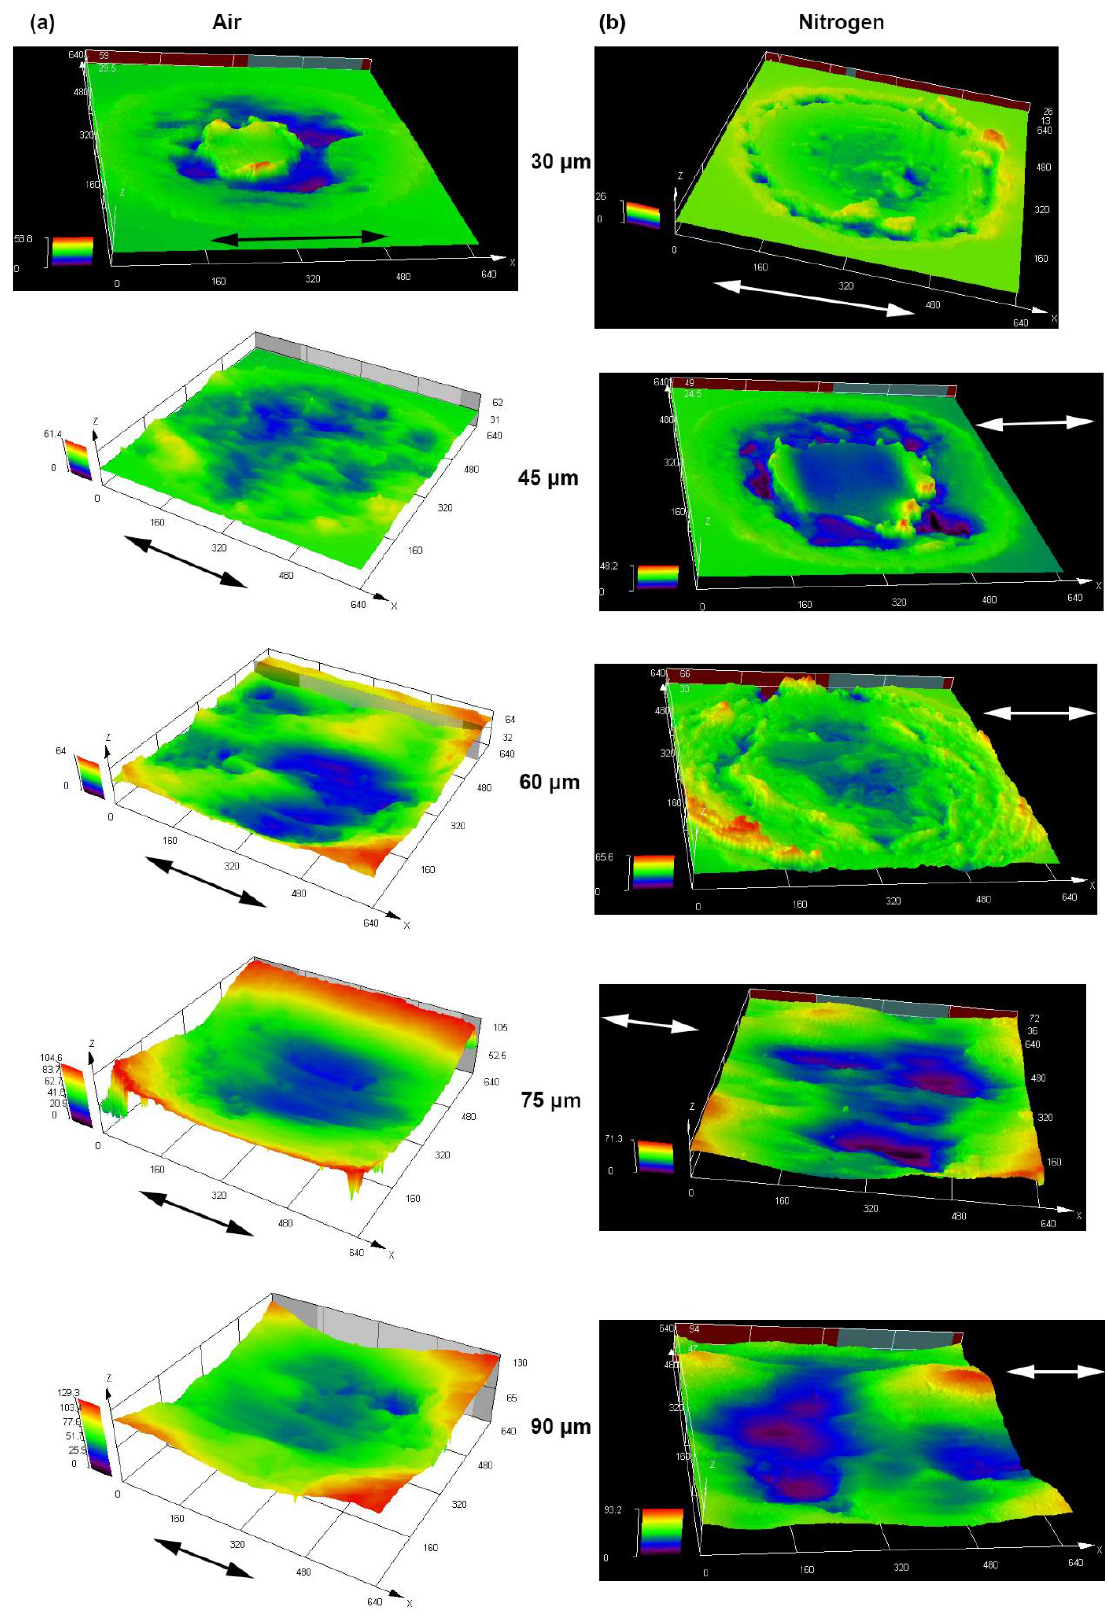
Figure 5. Three-dimensional-profile micrographs of alloy 690 during fretting wear at different displacement amplitudes in ( a ) air and ( b ) nitrogen. The arrows indicate the fretting direction.